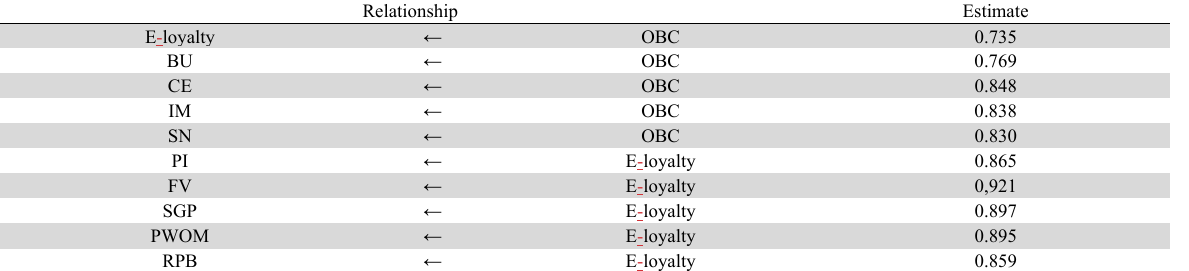
Measurement Model Estimation